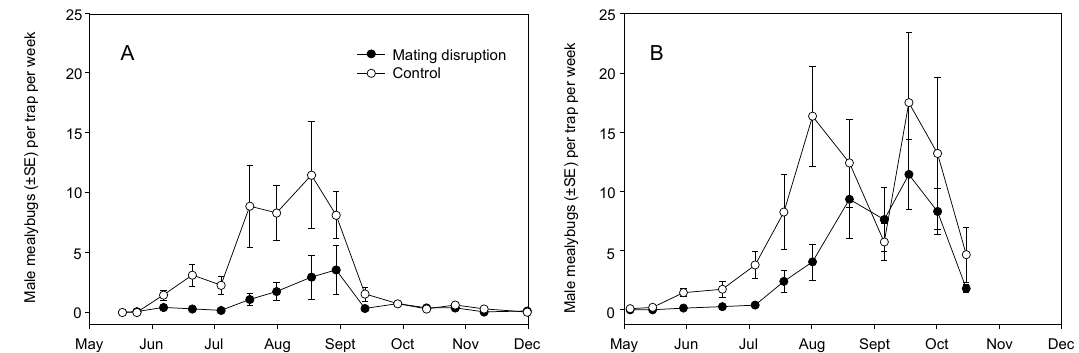
Figure 8. Season-long adult male Pl. ficus (mean ± SEM) captures in pheromone-baited traps in plots with CheckMate dispensers hung at 61.5 g/ha were lower than the control in ( A ) 2006 and ( B ) 2007. Harvest rating of fruit clusters showed no treatment effect in 2006 ( χ 2 = 6.018, df = 3, p = 0.111) with